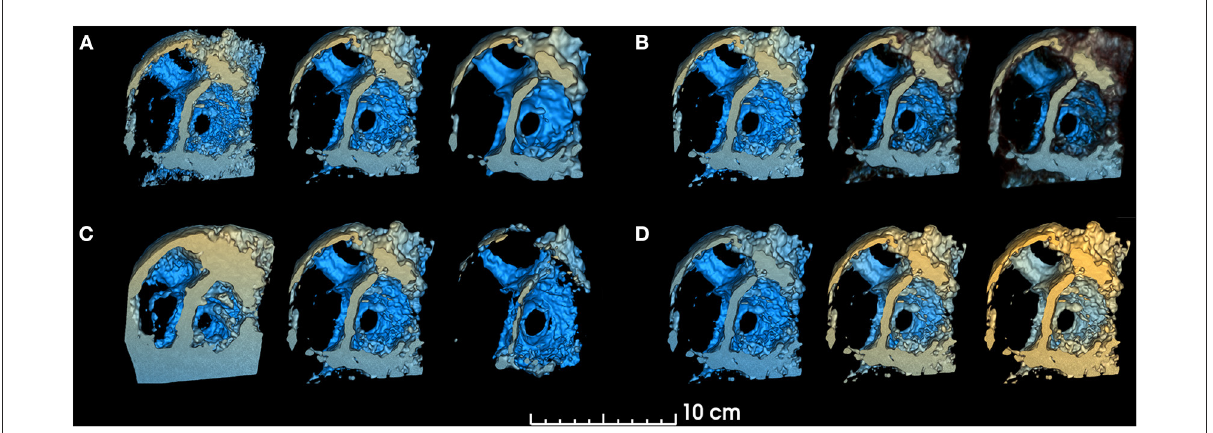
FIGURE1 Smoothing, threshold, edge smoothing and depth range parameters. changes in volume rendered model for different values of (A) . Smoothing (left: 0.25, center: 1.0, right: 1.75), (B) Threshold (left: 30%, center: 50%, right: 70%), (C) Edge smoothing (left: 0%, center: 10%, right: 20%), (D) Depth range [left: ( − 150, + 10), center: ( − 103, + 40), right: ( − 103, + 80)]. Unchanged parameters have remained constant at the following value: Smoothing factor = 1.00, Threshold = 50.9%, Edge smoothing = 2.0%, Depth range = [ − 103, 10], Depth darkening = 30.0%, Depth coloring = [ − 24.35, 23.55%], Brightness = 165%, Saturation = 200%.